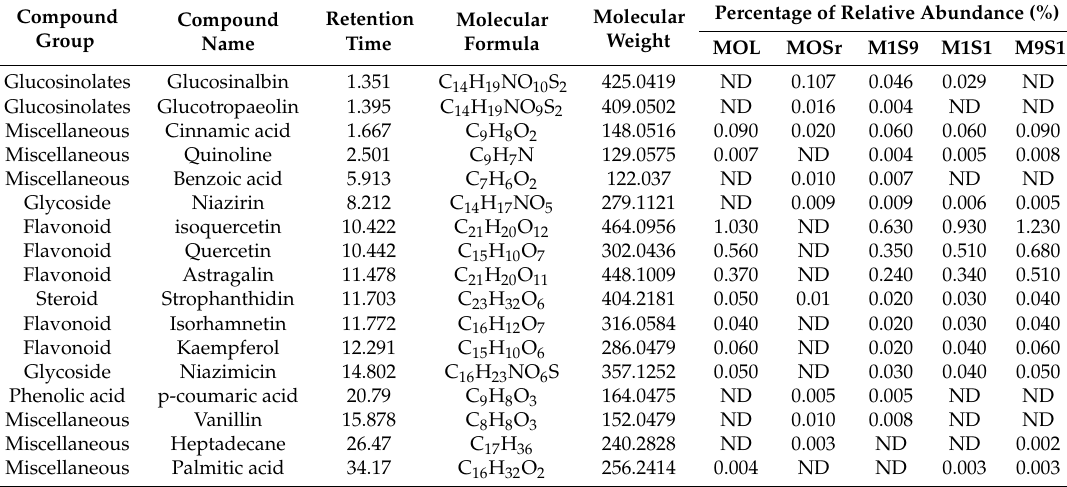
Table 2. List of compounds identified in the moringa leaves (MOL), moringa seed residue (MOSr) and combined mixture of moringa leaves and seed residue (MOLSr) extracts at di ff erent ratios (M1S9, M1S1 and M9S1) according to retention time, molecular weight and metabolite classification.